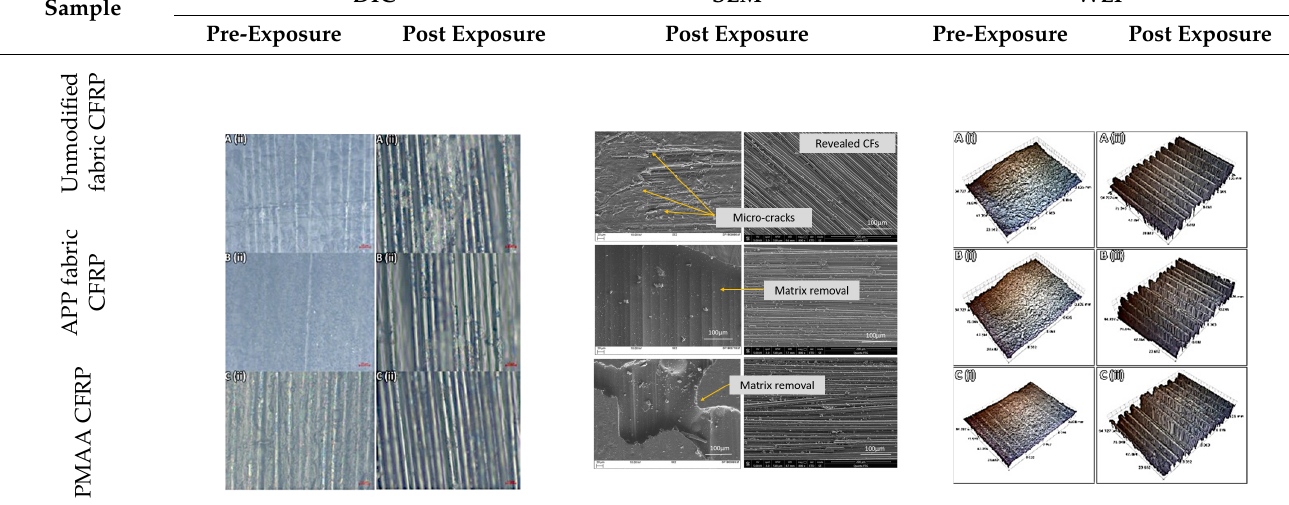
Table 5. Surface morphology assessment after 1000 h of accelerated weathering.